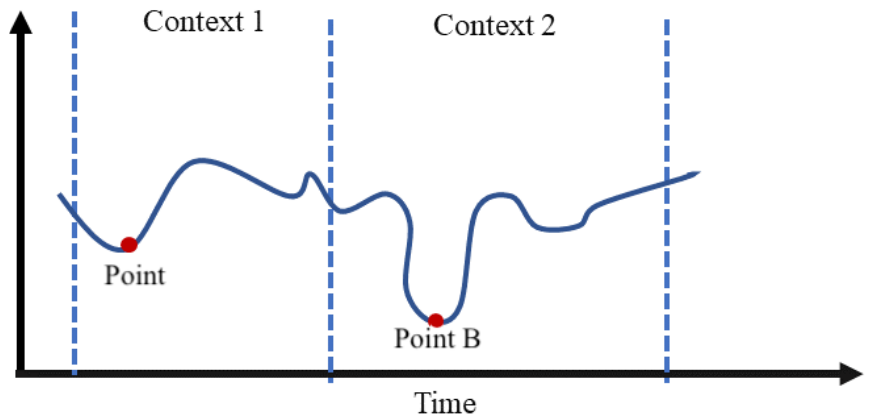
Figure 4. Contextual anomaly detection.